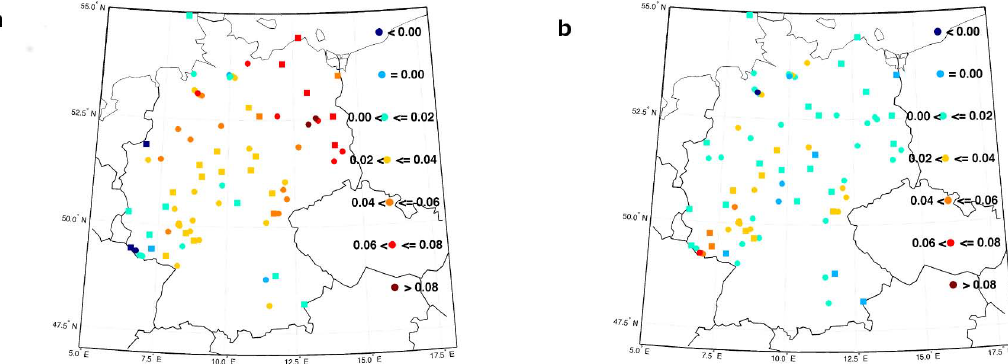
Fig. 8. Difference of daily correlation coefficient for SO 2 between the model simulations using the new (LE_SNAP2, LE_SNAP1) and the default (LE_Default) emission time profiles for SNAP2 (a) and SNAP1 (b) across German urban (circle) and rural (squares)